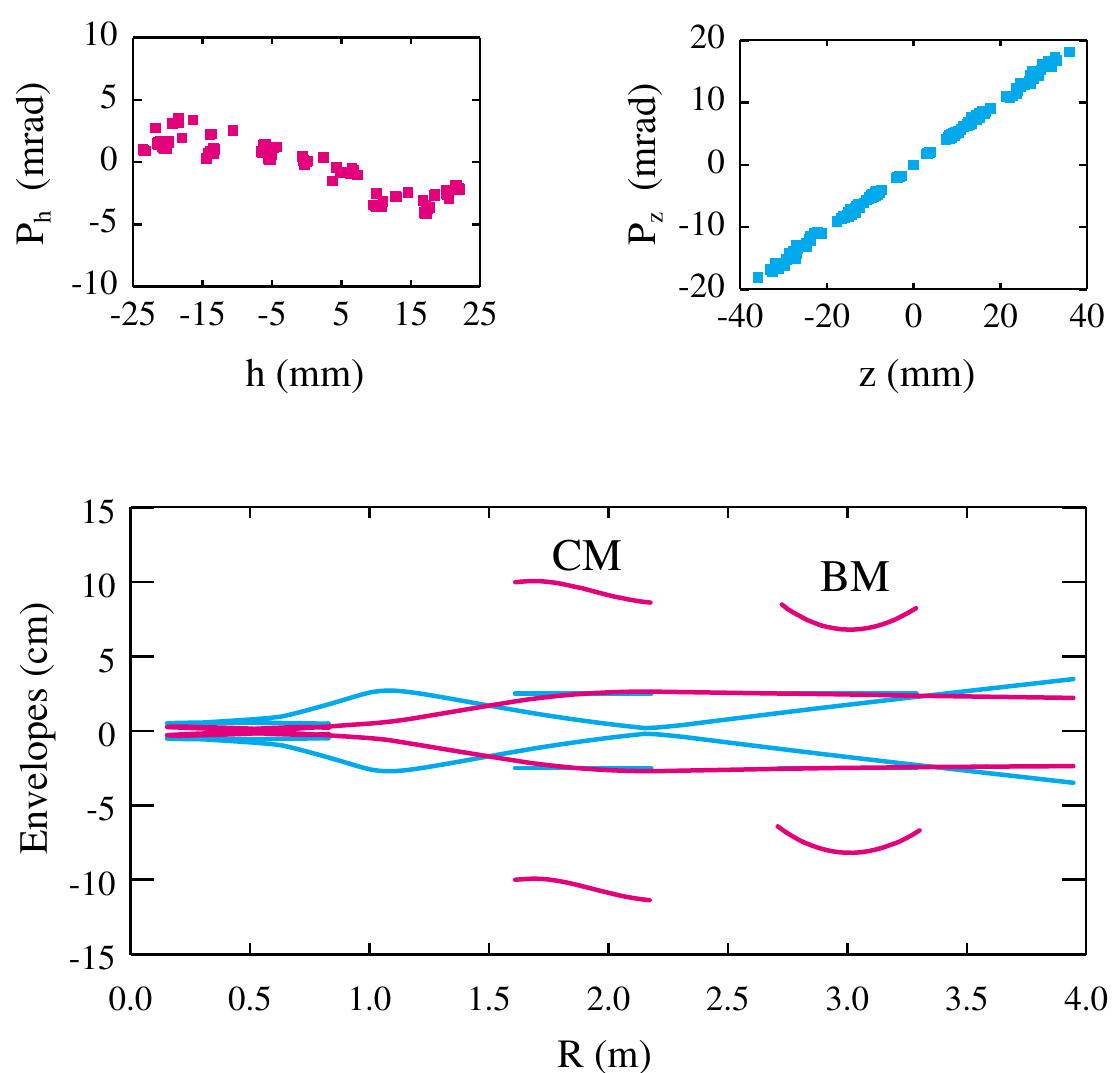
FIG. 8. (Color) Beam emittances and envelopes for K (cid:4) 2 . The structure of the figure is the same as that of Fig. 7. The represented (cid:3) ion beam accelerated to 30 MeV per nucleon. The combined and bending magnet beam of protons was obtained from the H 2 (cid:4) (cid:2) 0 : 123 20 T , G (cid:4) 1 T = m , and B (cid:4) (cid:2) 0 : 290 61 T . The aperture of parameters used in the beam dynamics simulation are B CM BM the combined magnet is only slightly distorted, so the beam central trajectory passes very close to the magnet axis. The horizontal emittance matches the transport line acceptance. The increase in G cannot further improve the vertical emittance to match the transport line acceptance due to the small vertical beam size in the combined